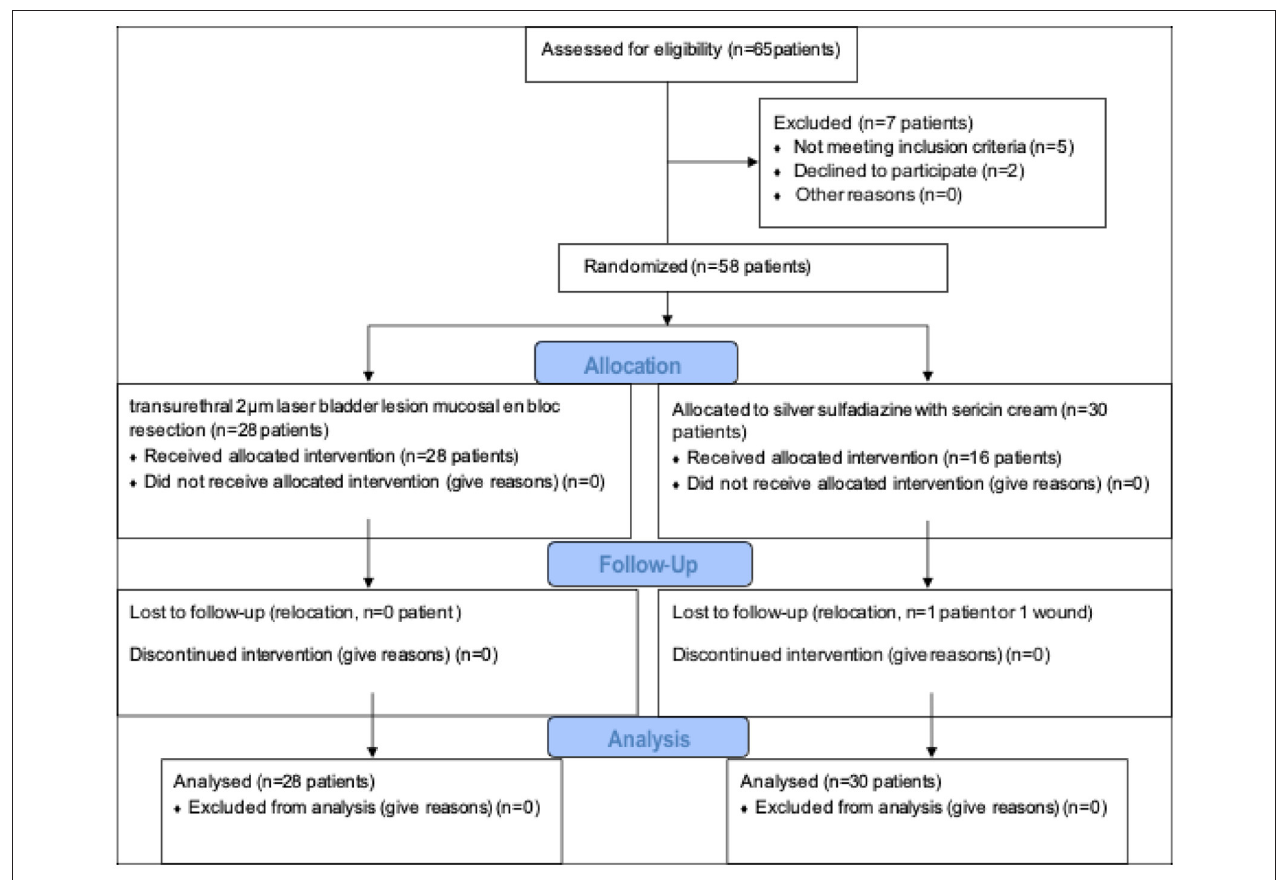
FIGURE 2 | CONSORT flow diagram.